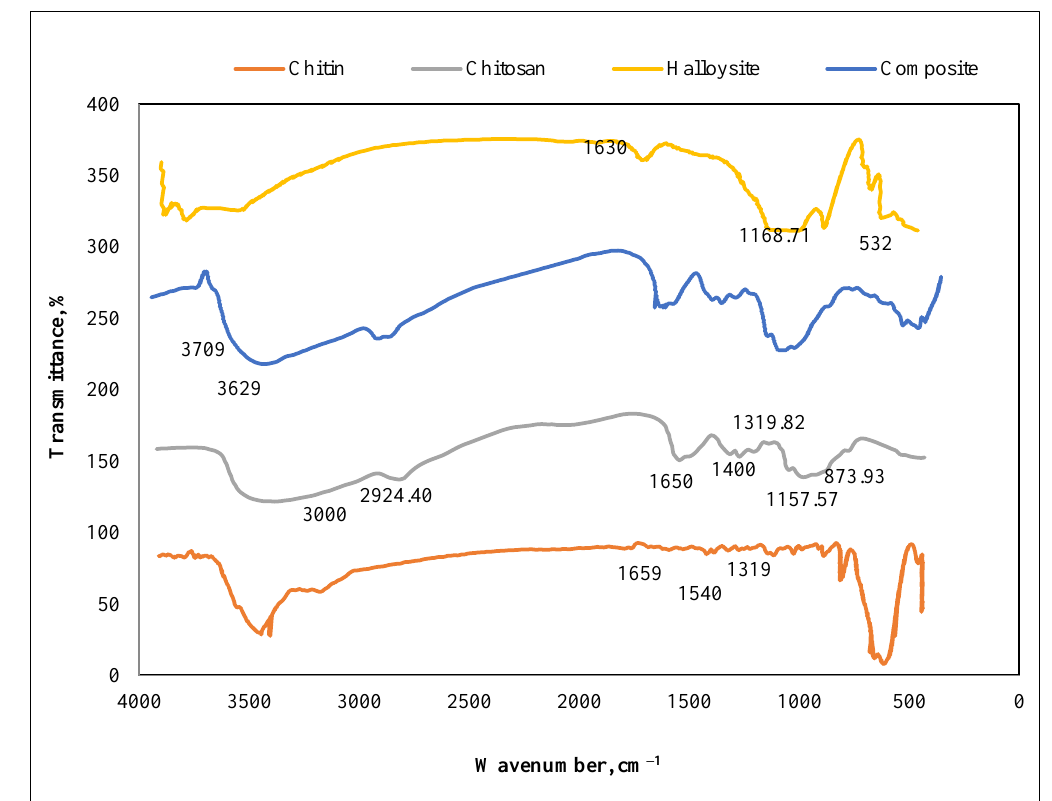
Figure 4. FTIR spectra of chitin, chitosan, halloysite, and composite.